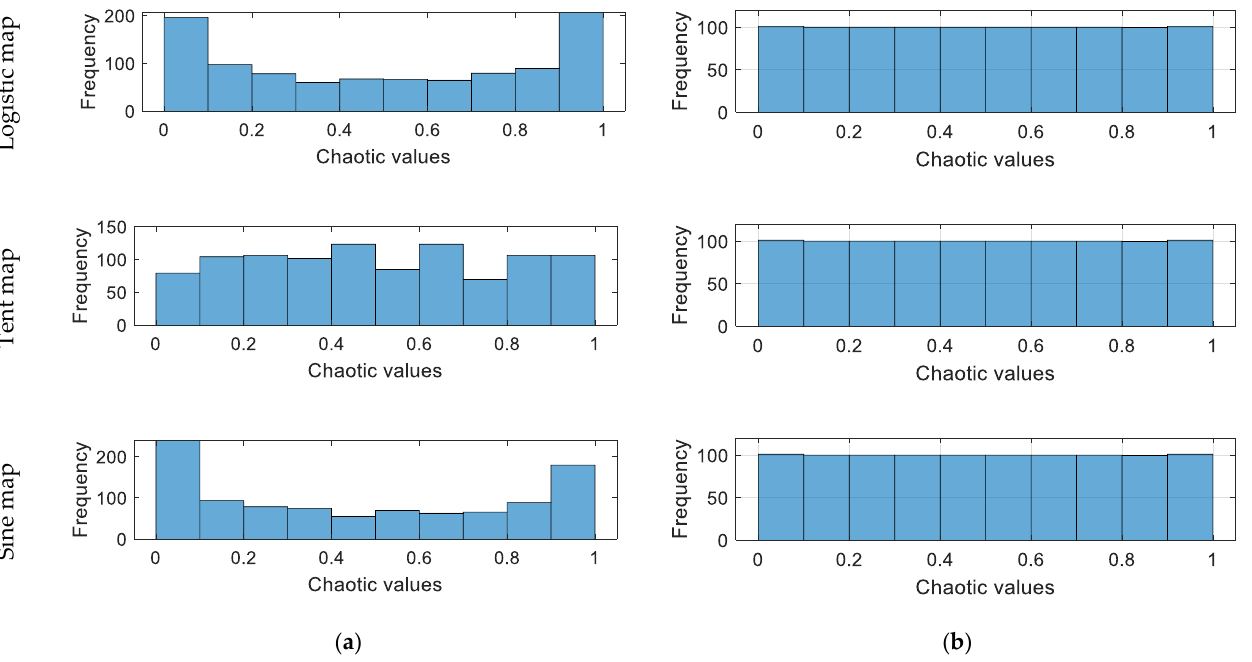
Figure 8. ( a ) Histograms of the chaotic sequences generated by logistic map, tent map and sine map, respectively, with ( b ) their histograms after equalizing the distribution of their sequences by using Algorithm 1.